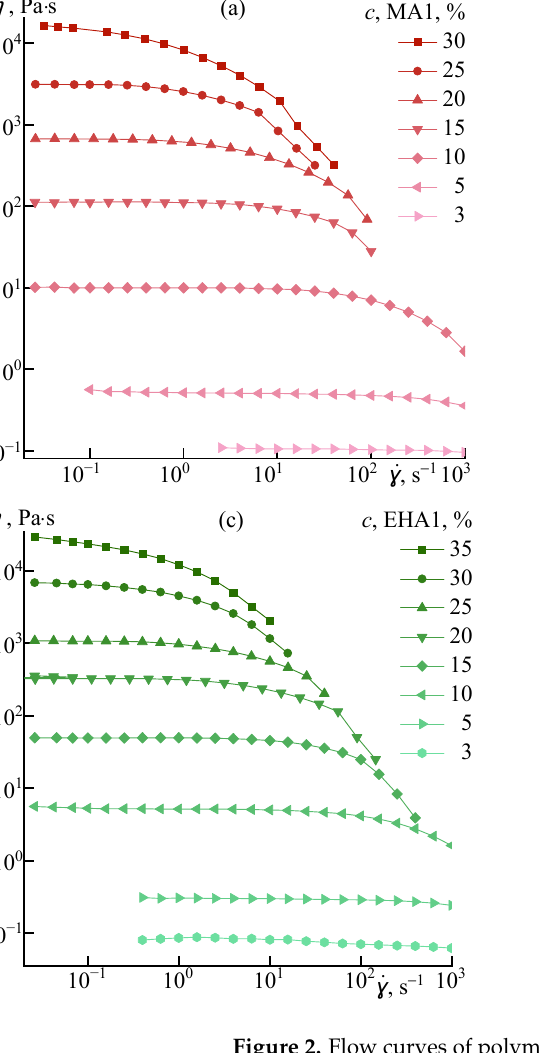
Figure 2. Flow curves of polymer solutions with M w ~150 kg/mol (AlkA1 rank) of various concentra- tions at 25 ◦ C, with various alkyl acrylates: ( a )—methyl acrylate; ( b )—butyl acrylate; ( c )—2-ethylhexyl acrylate; ( d )—lauryl acrylate. The concentrations are indicated in the